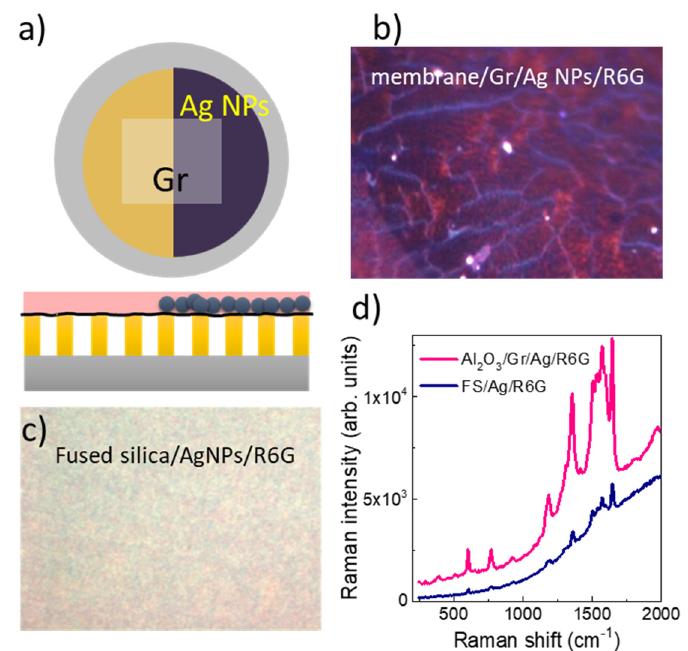
Figure7. ( a )Schemaofthemembranebasedamplificationplatform: supportedmembrane / graphene / Ag Figure 7. ( a ) Schema of the membrane based amplification platform: supported NPs / R6G, top view and cross section, ( b ) optical image of the Ag NPs region and ( c ) of the fused membrane/graphene/Ag NPs/R6G, top view and cross section, ( b ) optical image of the Ag NPs region silica / graphene / Ag NPs / R6G reference sample (images of 36 µ m × 27 µ m regions). ( d ) Typical R6G and ( c ) of the fused silica/graphene/Ag NPs/R6G reference sample (images of 36 µm × 27 µm regions). Raman spectra from both ( d ) Typical R6G Raman spectra from both samples.